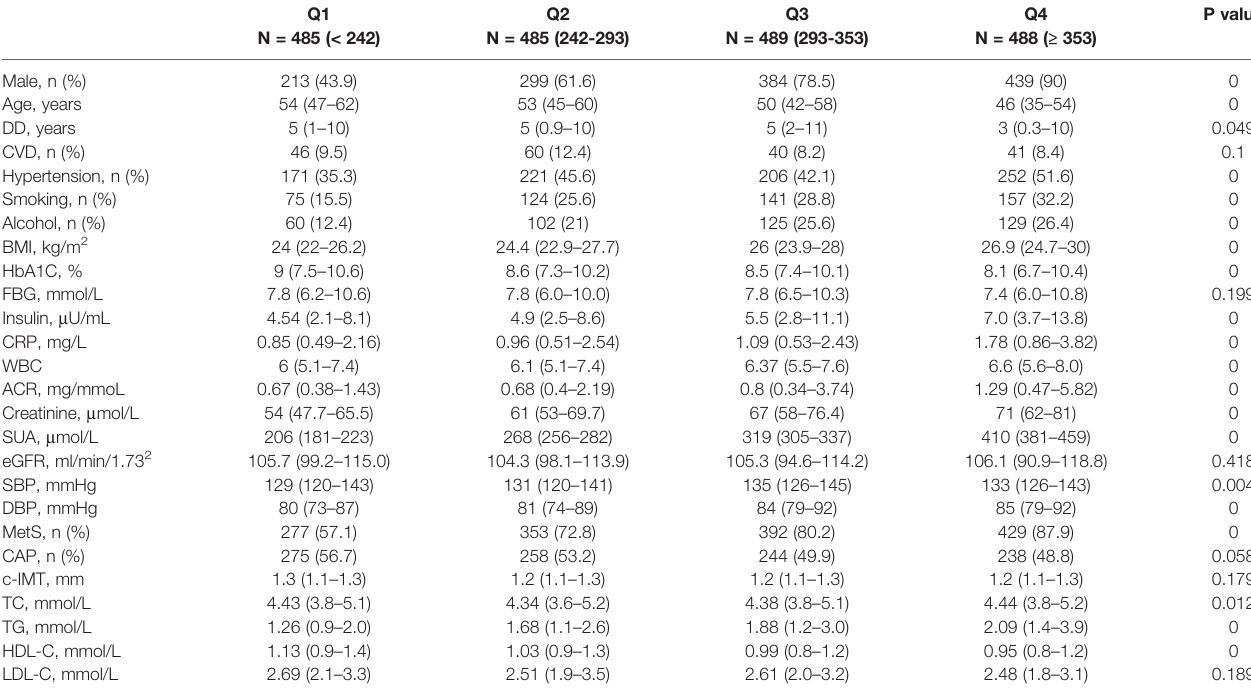
TABLE 1 | Characteristics of study participants according to uric acid quartiles. Q1